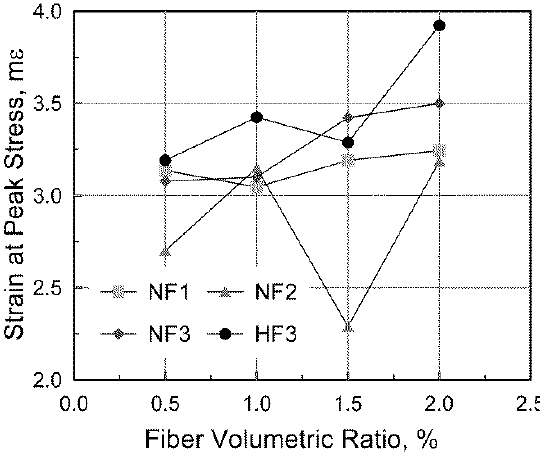
Figure 3. Measured compressive strain at the compressive